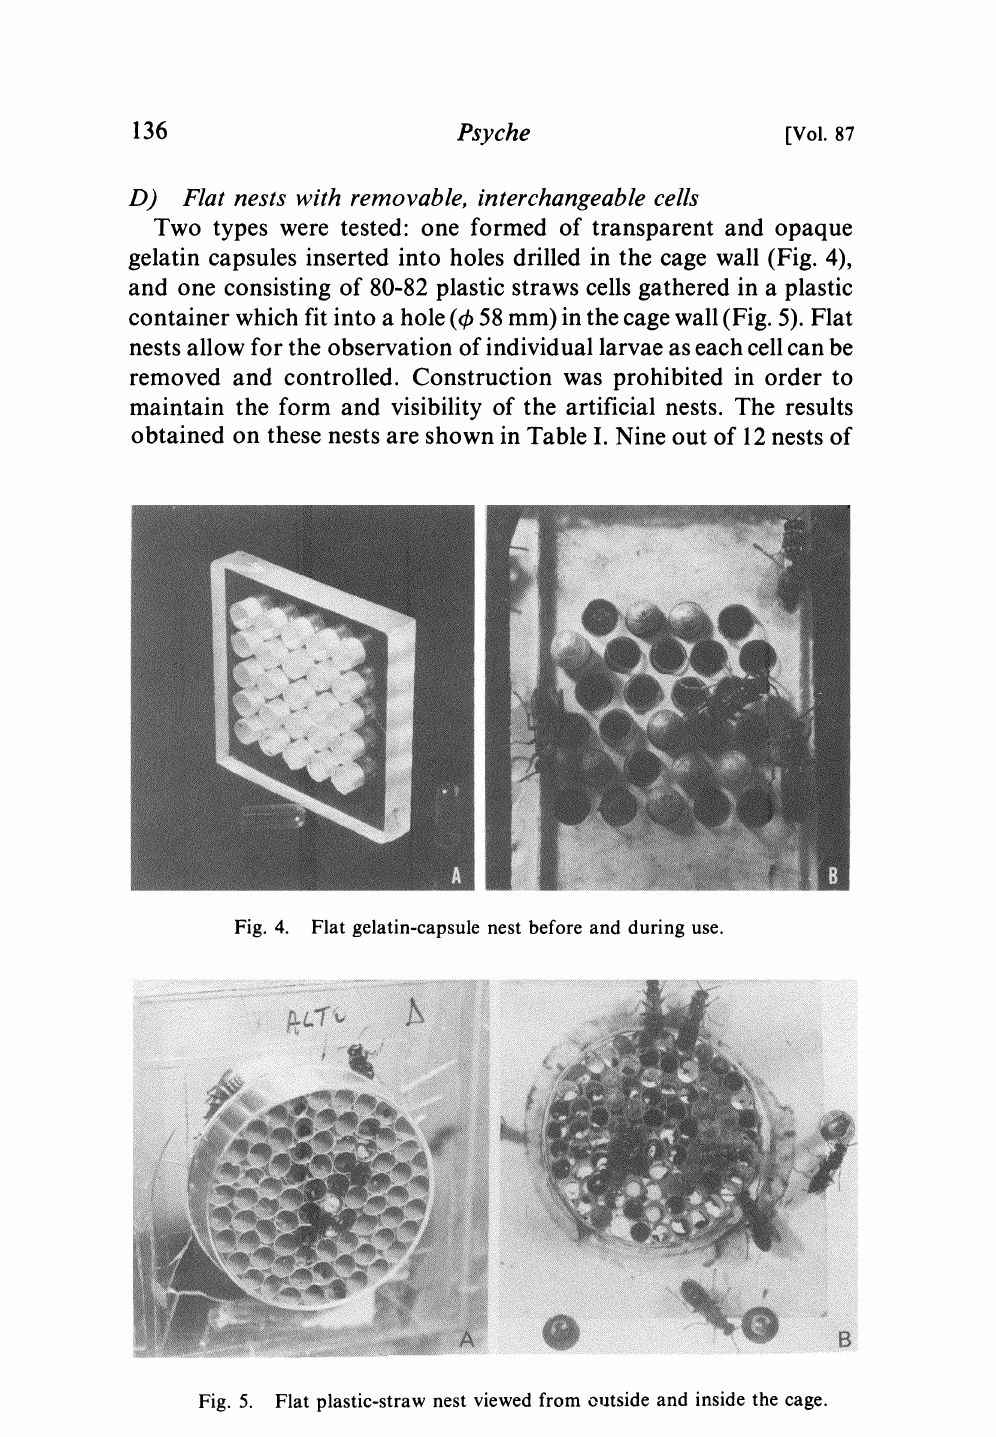
Fig. 5. Flat plastic-straw nest viewed from outside and inside the